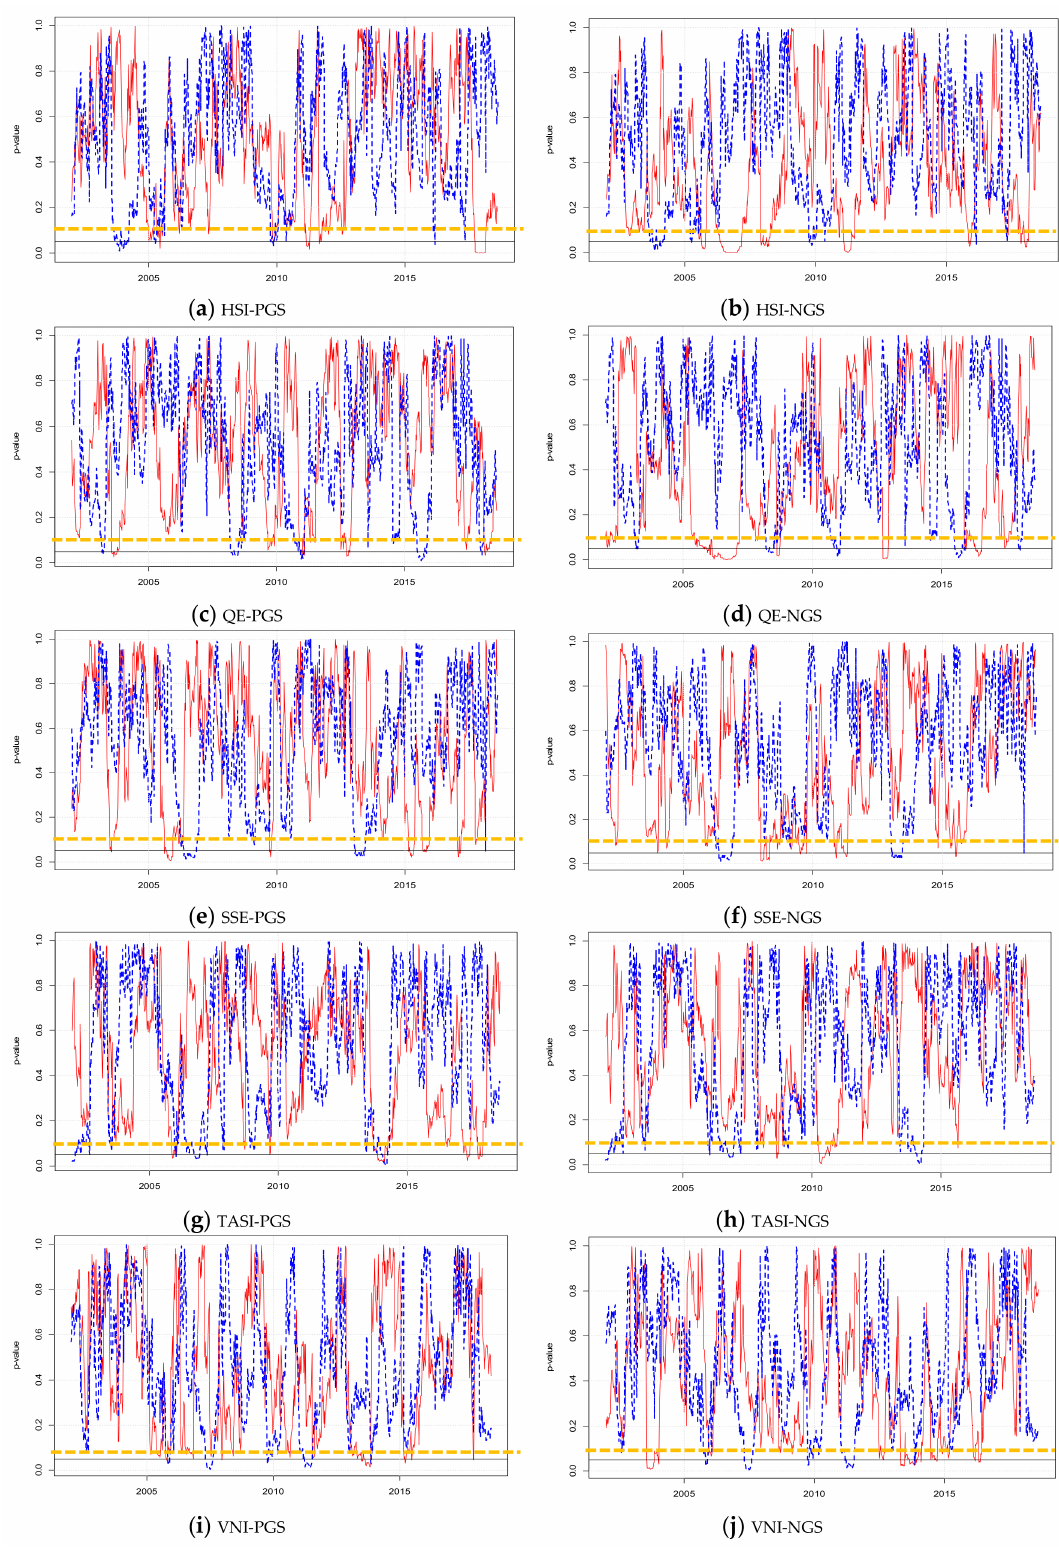
Figure 2. Rolling window bootstrapped p -values of LR test statistic testing of 10 pairs: HSI -PGS, QE-PGS, SSE-PGS, TAD-PGS, VNI-PGS, HSI -NGS, QE -NGS, SSE-NGS, TAD-NGS, and